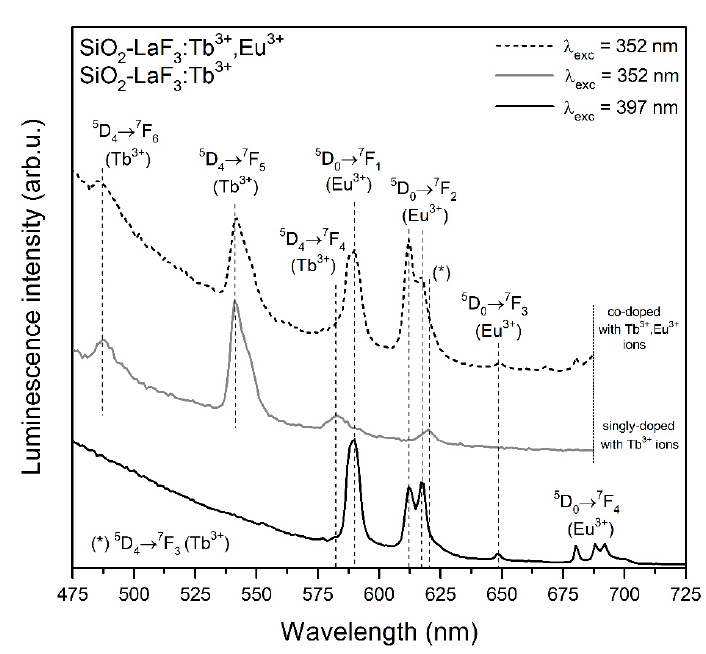
Figure 8. PL spectra of SiO 2 -LaF 3 :Tb 3 + and SiO 2 -LaF 3 :Tb 3 + , Eu 3 + samples recorded under NUV excitation at λ exc = 352 nm and λ exc = 397 nm.